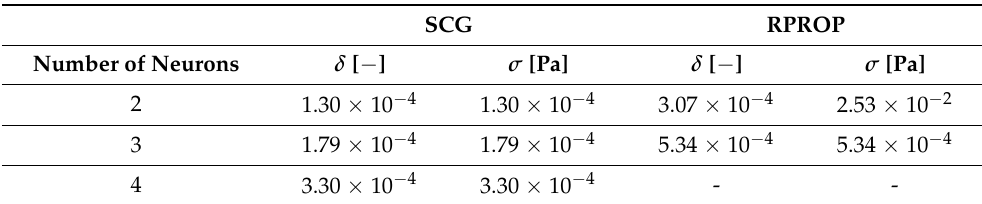
Table 2 summarises the averaged absolute values of the relative error and its stand- ard deviation for the selected training algorithms and the number of neurons in the layer. The results were obtained for a network with one hidden layer, as this network has the lowest error rate compared to networks with more layers. Table 2. Absolute value of the mean relative error δ and its standard deviation σ for selected training algorithms and the number of neurons in one hidden layer. SCG RPROP Number of Neurons δ [ − ] σ [Pa] δ [ − ] σ [Pa] 2 1.30 × 10 − 4 1.30 × 10 − 4